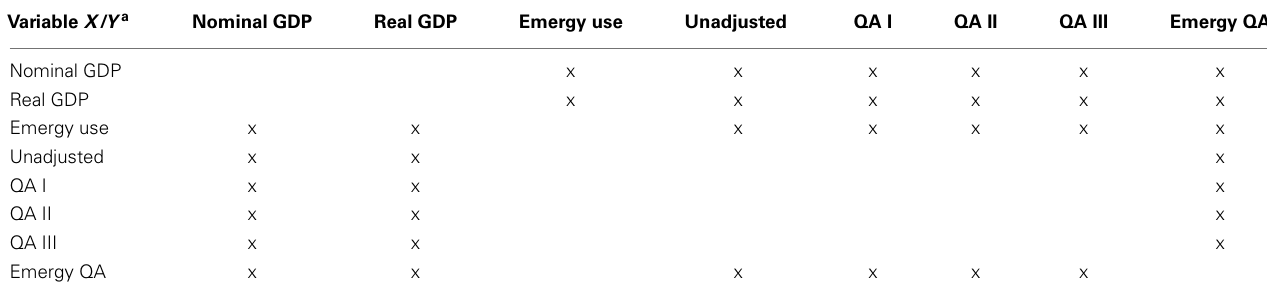
Table 1 | Pairs of emergy, energy, and economic variables for which relationships were explored in this paper, where unadjusted, QA I, QA II, QA III, and Emergy QA are the energy consumption variables (see Energy Methods)